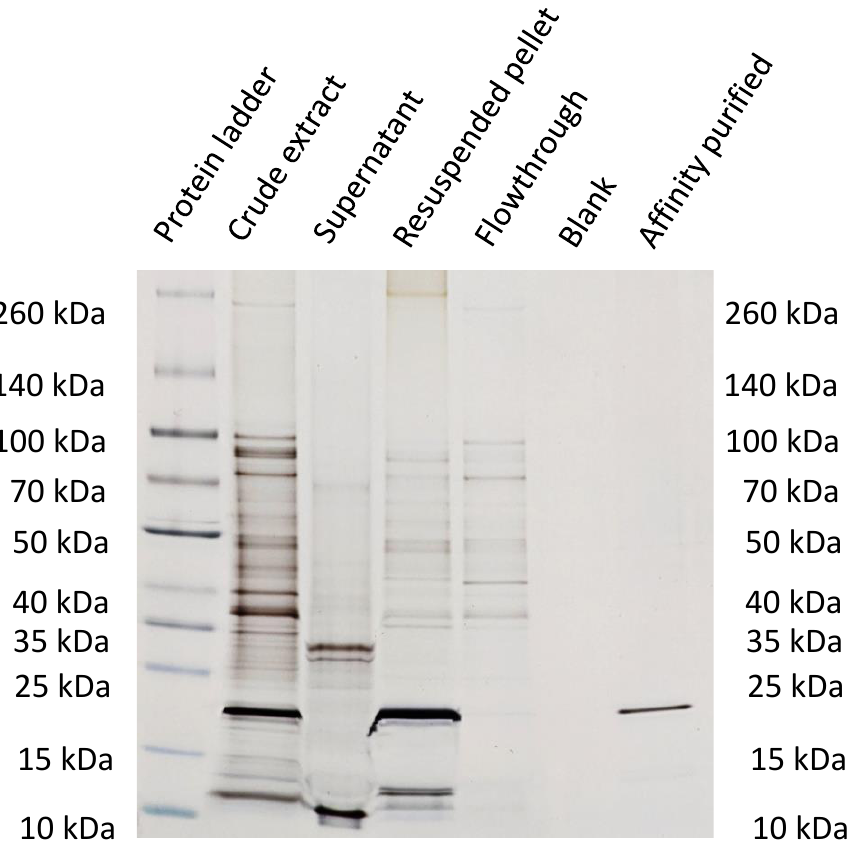
Figure 8. Silver-stained SDS-PAGE analysis of each purification step and the final eluate. Lane 1: Protein ladder; Lane 2: Crude extract; Lane 3: Supernatant after precipitation with PEG 8000; Lane 4: Supernatant of resuspended pellet; Lane 5: Flowthrough of affinity column; Lane 6: Binding buffer as blank; Lane 7: CCMV eluate obtained by affinity purification (final product, diluted to approx. 20 µg/mL).